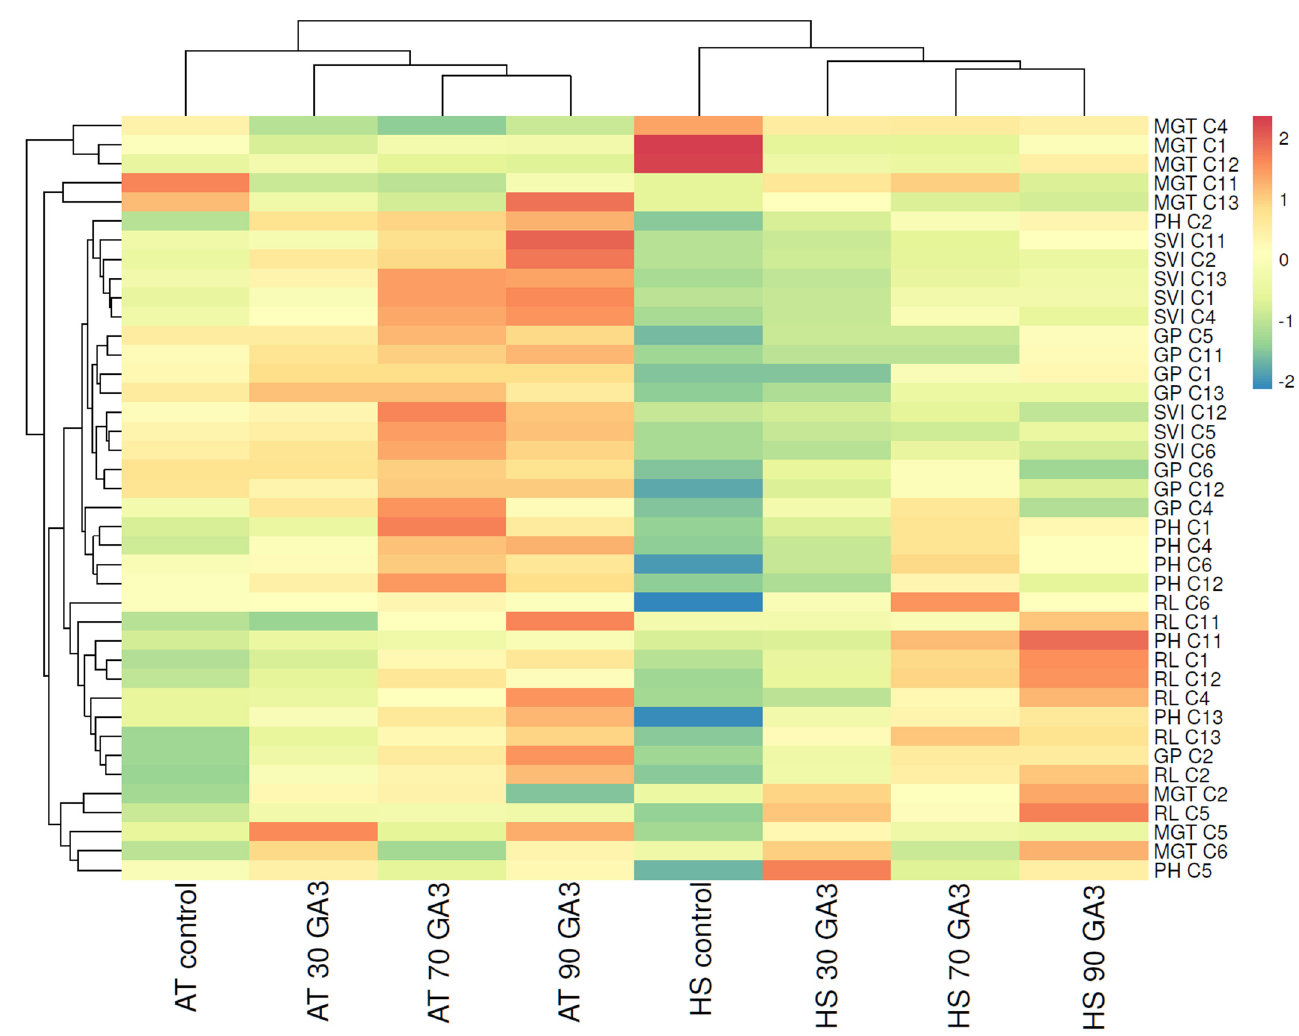
Figure 6. Hierarchical clustering and heatmap visualization of heat-sensitive genotypes under ambient temperature and heat stress conditions. Columns indicate the control and GA 3 treatments, and rows indicate morphological parameters. Cells are colored based on values of seed and plant development, where red represents a strong positive correlation and blue a strongly negative correlation.